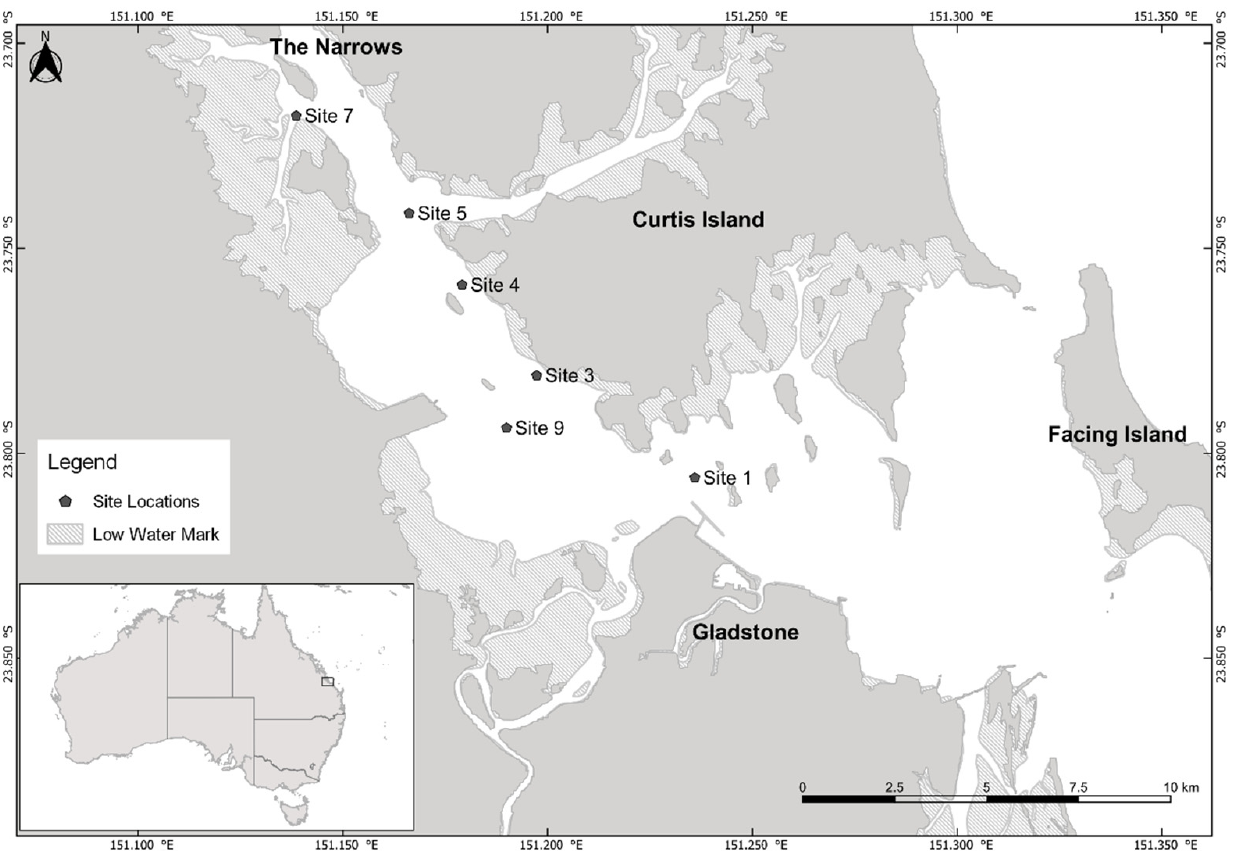
Figure 1. Port Curtis during the period of sampling and locations of the lower-estuary (Site 1), mid-estuary (Sites 3, 4, and 9), and upper-estuary (Sites 5 and 7) LISST profiling sites.